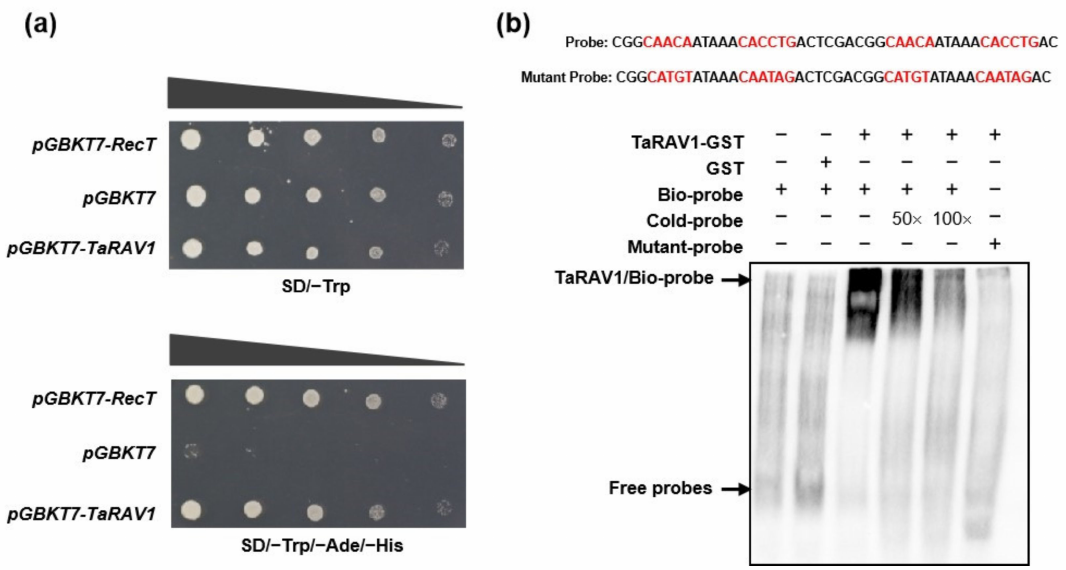
Figure 5. Transcription activation and DNA binding activities of TaRAV1. ( a ), Growth of yeast cells expressing TaRAV1 on selection media. Plasmid pGBKT7-TaRAV1 was transferred into Yeast AH109 , and transformants were spotted on SD/ − Trp medium (SD minimal medium lacking Trp, upper panel) and SD/ − Trp/ − Ade/ − His medium (SD minimal medium lacking Trp, Ade and His, lower panel). Yeast cells harboring pGADT7-RecT were used as a positive control; yeast cells harboring pGBKT7 empty vector were used as a negative control. ( b ), EMSA DNA binding assay. GST-tagged TaRAV1 protein was expressed and purified from E. coli . The probes containing the canonical cis- elements (CAACA and CACCTG) or mutated elements were labeled with biotin for incubation with TaRAV1-GST protein. Unlabeled probes were added for the competition assay. GST protein was used as a negative